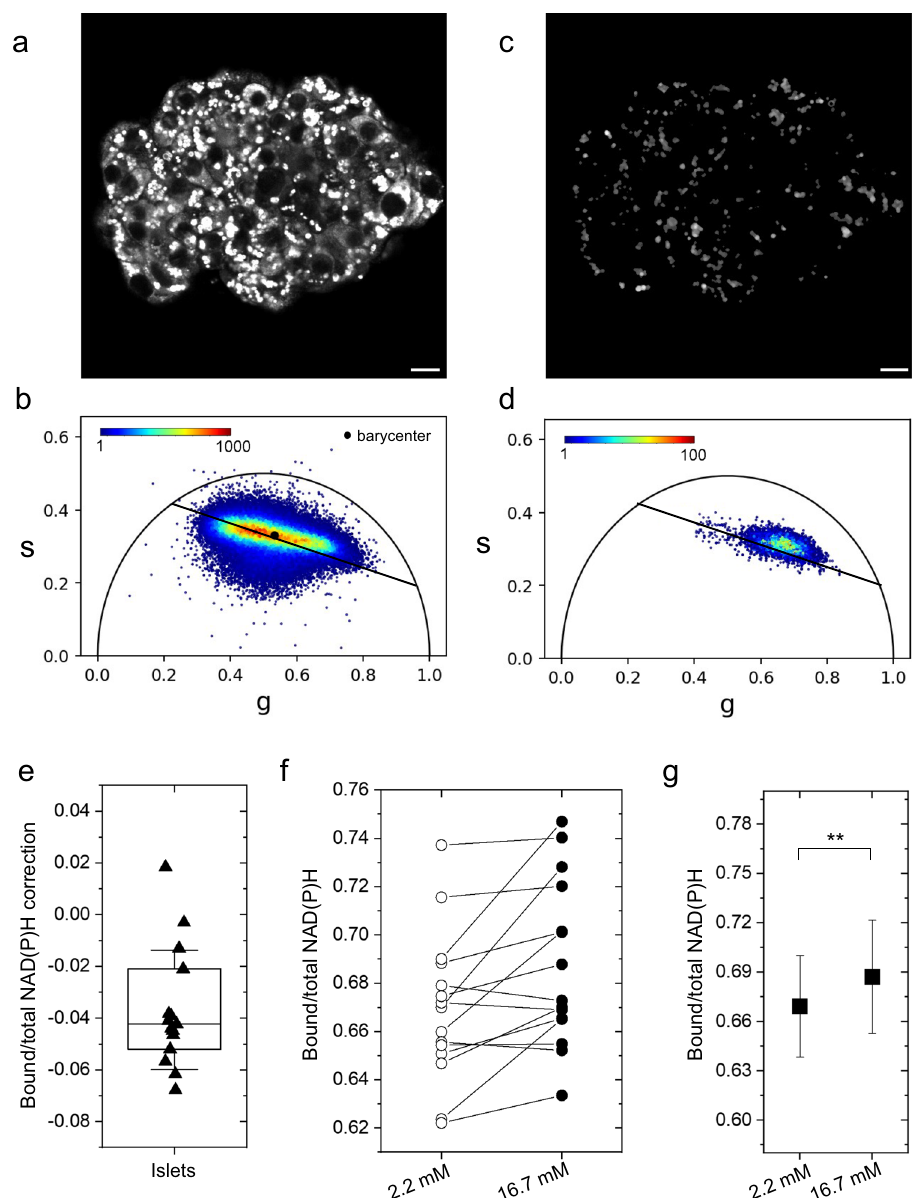
Fig. 2 FLIM imaging and lipofuscin subtraction in living human islets. a , b Likewise immortalized cells, FLIM images of living human islets depict the distribution of fl uorescence intensity with each pixel having a corresponding point in the phasor plot. The islet metabolic status can be modeled using the phasor barycenter and its movement along the metabolic axis upon increasing glucose concentration from 2.2 and 16.7 mM. Before assigning signals to NAD(P)H, the contribution of lipofuscin bodies ( c ) needs to be subtracted. Lipofuscin signal ( d ) potentially interferes with barycenter calculus, causing barycenter displacement towards free NAD(P)H condition ( n = 15 islets) ( e ), yielding lipofuscin correction a necessary task for the correct identi fi cation of islet metabolic state. Considering the islet as a whole, metabolic response for glucose stimulation ( n = 15 islets) displays mild to moderate bound-shift ( f ), yielding a statistically signi fi cant bound-shift on average ( n = 15 cells) ( g ), presumably due to the higher amount of β cells in the islet which thus have higher contribution in barycenter calculus. At this point, no cell type recognition has been performed yet. Statistical difference obtained using Paired Samples Wilcoxon Test, with signi fi cance α = 0.05 (** P < 0.01). Scale bar: 20 μ keeping with previous systematic studies conducted on human the calculation of the metabolic shift (Fig. S4c, d). At this point, islets 30 . Lipofuscin was subtracted by introducing a fi lter based on the signal left after lipofuscin subtraction was attributed to the intensity (see “ Methods ” for further details). This correction NAD(P)H auto- fl uorescence, and the basic experiment of glucose eliminates a lifetime component with a peculiar location in the stimulation was performed by acquiring two consecutive FLIM phasor plot, i.e., close to free NAD(P)H on the metabolic segment images for each islet: the fi rst at low glucose concentration (Fig. 2d), that would affect the estimate of the phasor barycenter (2.2 mM, after incubation in the SAB solution for 45 min), the and the calculation of the bound/total NAD(P)H ratio (Fig. 2e). second after exposure of the islet to high glucose concentration Yet it must be noted that, since the amount of lipofuscin does not (16.7 mM). All stimulated islets were measured within 15 min change after stimulation, its subtraction has a negligible effect on from glucose administration. The corrected bound/total NAD(P)